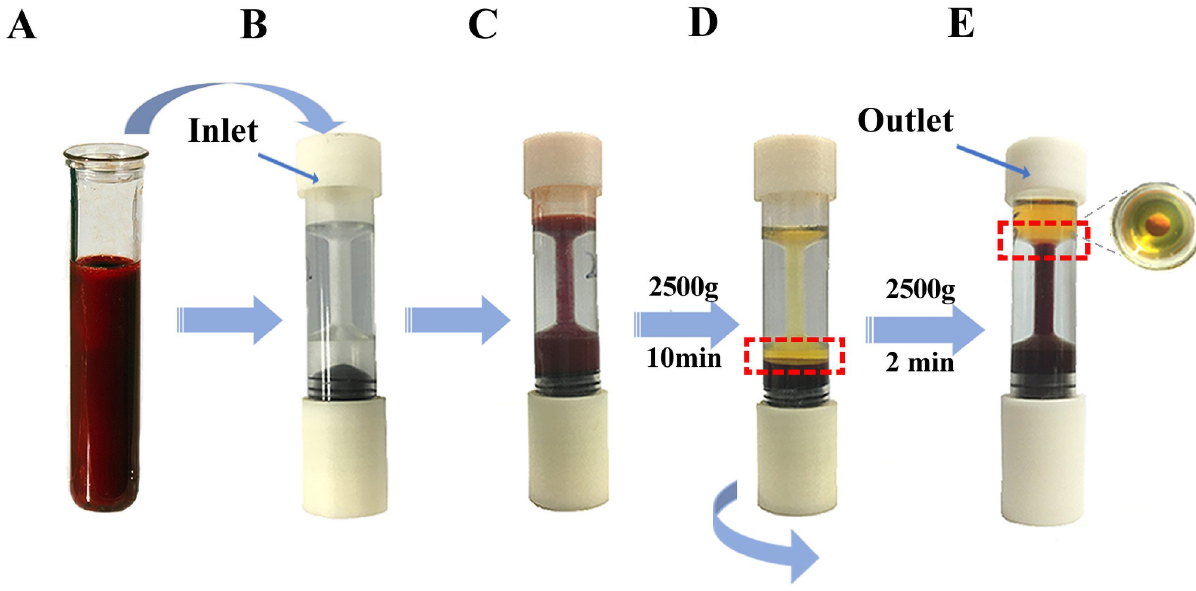
Fig 2. Processing of leukocyte extraction by LSA-3 the pushing style method. (A) 2–3 ml of whole blood was being prepared. (B, C) The sample is filling in the lower funnel chamber. (D) The buffy coat (red rectangle) was formed by centrifuging at 2500g for 10min. (E) with anticlockwise rotating the threaded-booster of the main body, the buffy coat layer (red rectangle) responds by moving up to the upper from the lower